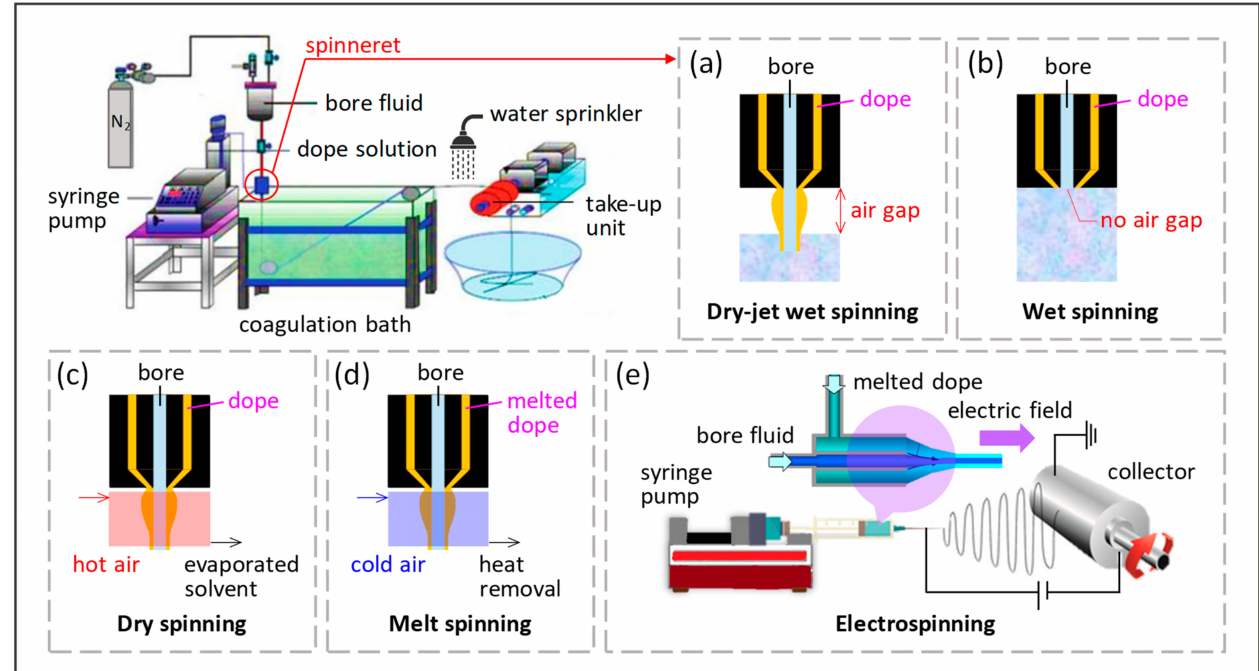
Figure 6. The illustration of different hollow fiber spinning techniques including ( a ) dry-jet wet- spinning, ( b ) wet spinning, ( c ) dry spinning, ( d ) melt spinning, and ( e )